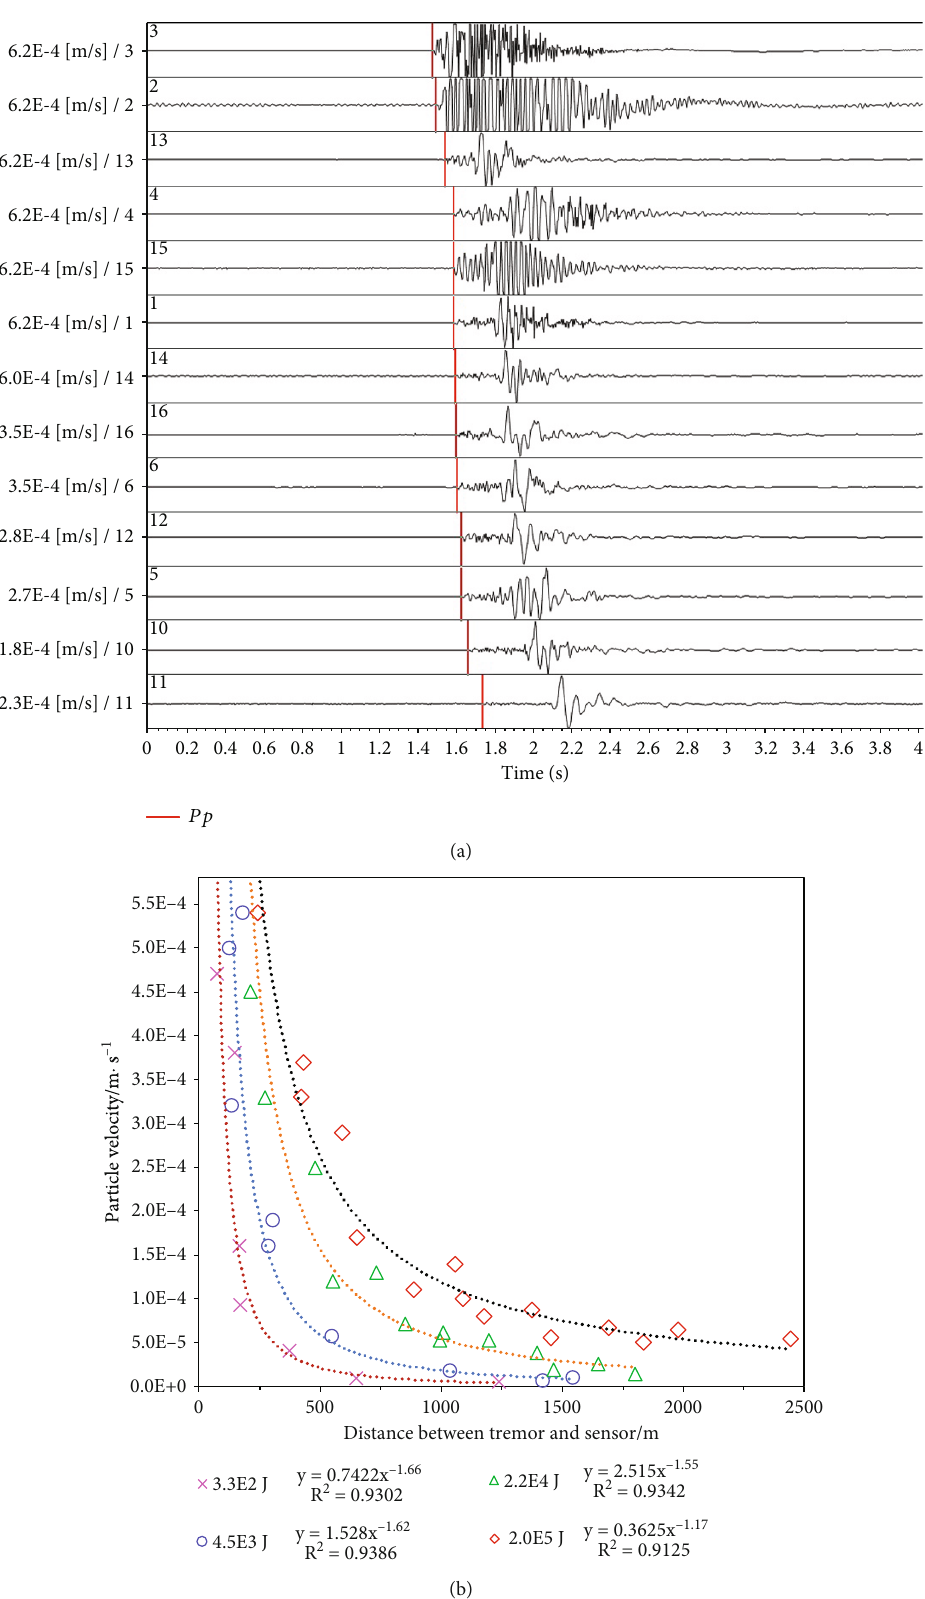
Figure 4: Calibration of the P-wave arrival time and typical seismic wave attenuation